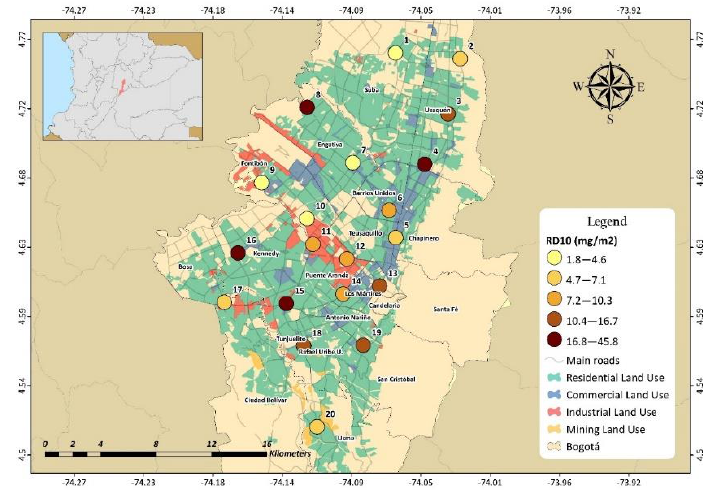
Figure 3. Spatial distribution of road dust loads in Bogotá.